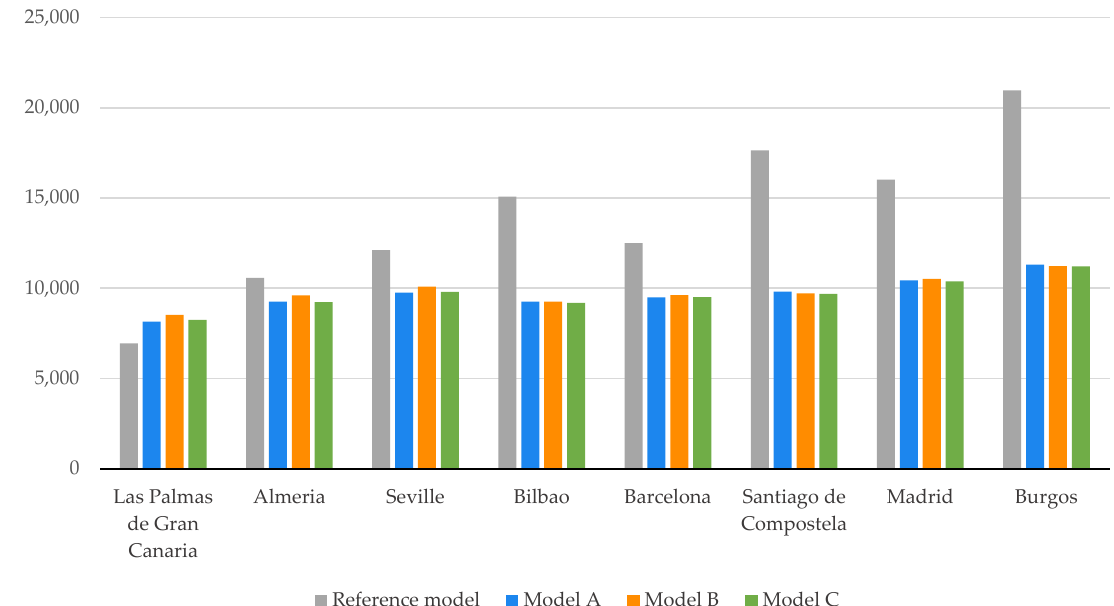
Figure 4. Total annual energy consumption (kWh) in the reference model (without insulation in the envelope) and the A-B-C renovation models in the eight cities. Las Palmas de Gran Canaria has a climate with moderate temperatures that remain relatively stable throughout the year. It can be seen in Table 5 how the maximum and minimum annual average outdoor temperatures are 23.4 ◦ C and 19.1 ◦ C, respectively, and differ by 4.3 ◦ C. According to current Spanish standards [58], the comfortable temperature inside a building is between 23 ◦ C and 25 ◦ C. Therefore, in this city, outside temperatures remain closer to the indoor comfort temperature, without so many annual or daily temperature fluctuations. That is why the reference model, without thermal insulation and with greater air infiltrations from the outside through the envelope, has lower energy consumption by taking advantage of these external privileged thermal conditions. Table 5. Annual average hourly outdoor temperature ( ◦ C) for each city.